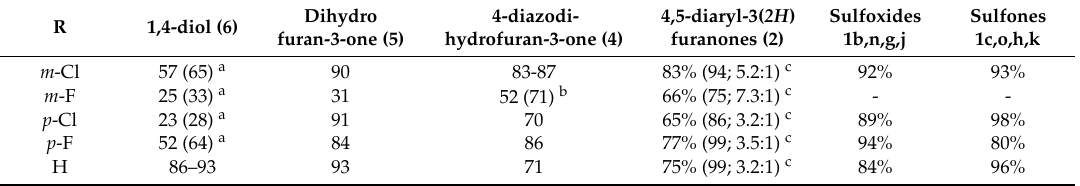
Table 2. Yields (%) of reactions on different steps of synthesis of sulfoxides and sulfones (Scheme 1). R